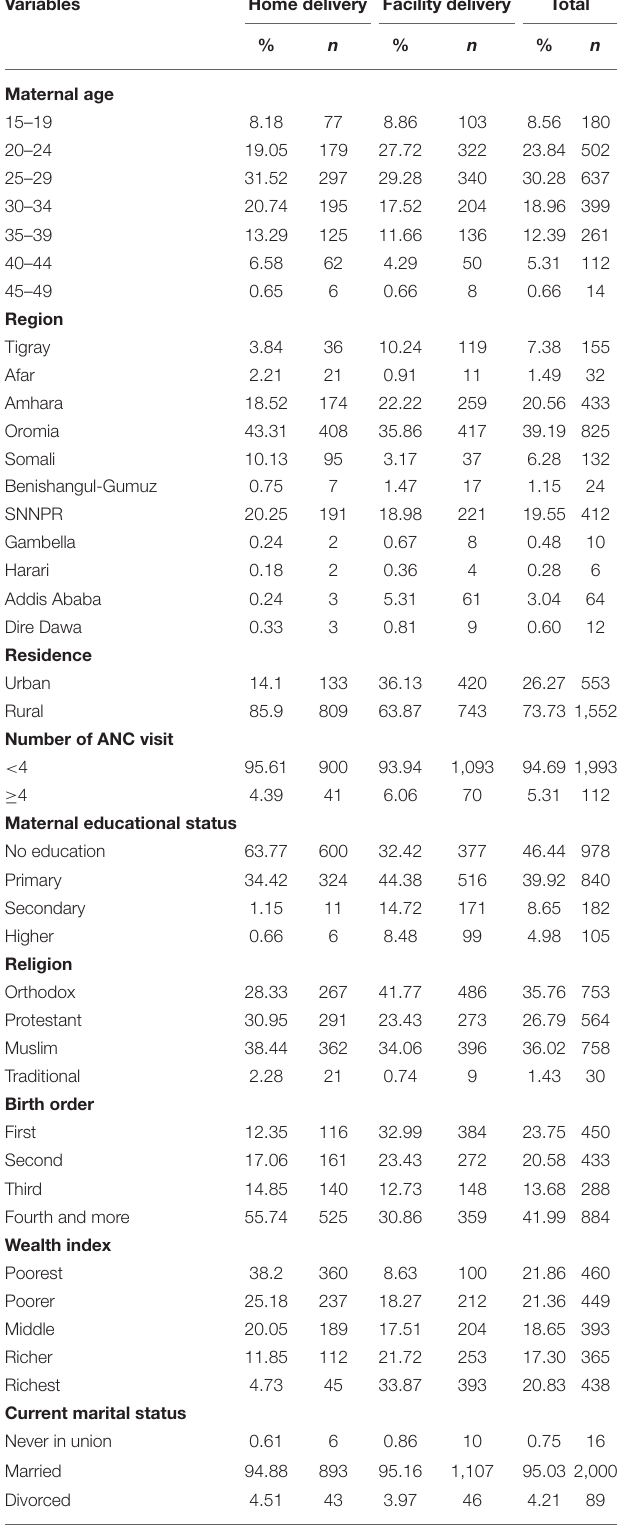
TABLE 1 | Characteristics of study participants according to the place of delivery in Ethiopia, 2019.